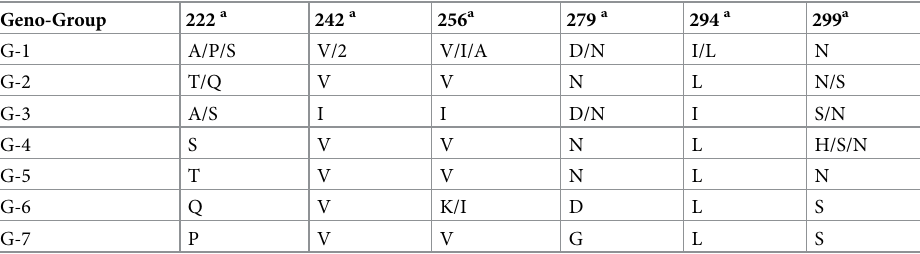
Table 2. Description of genetic markets in different geno-groups. Geno-Group